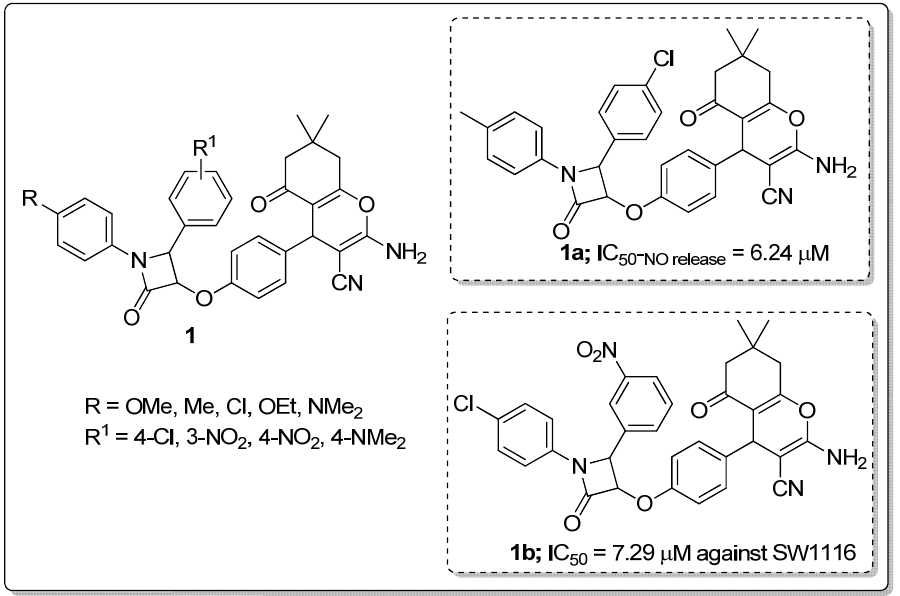
Figure 3. Anti ‐ inflammatory (compound 1a ) and anti ‐ cancer activity (compound 1b ) of the most active chromeno ‐β‐ lactam